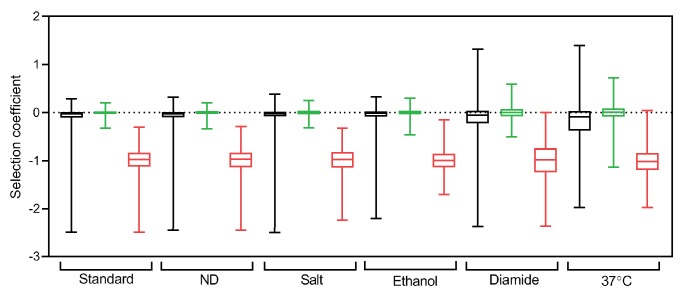
Distribution of selection coefficients for non-synonymous mutations (black), wild-type synonyms (green), and stops (red) in each environmental condition.